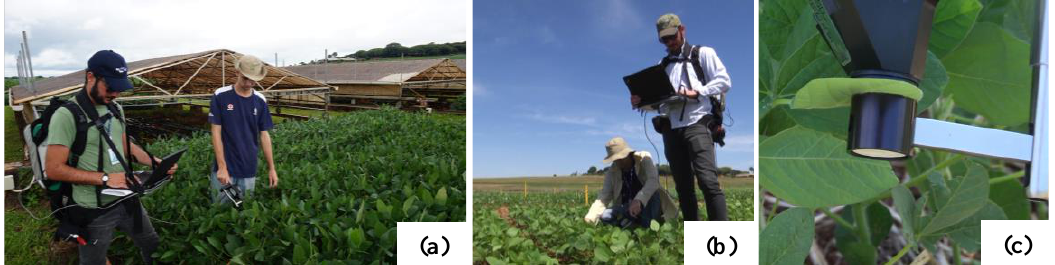
Figure 5. Spectral assessment in the field ( a and b ) and detail of the plant probe device ( c ). Figure 5 ( b and c ): Photo by Décio de Assis — Embrapa Soja.